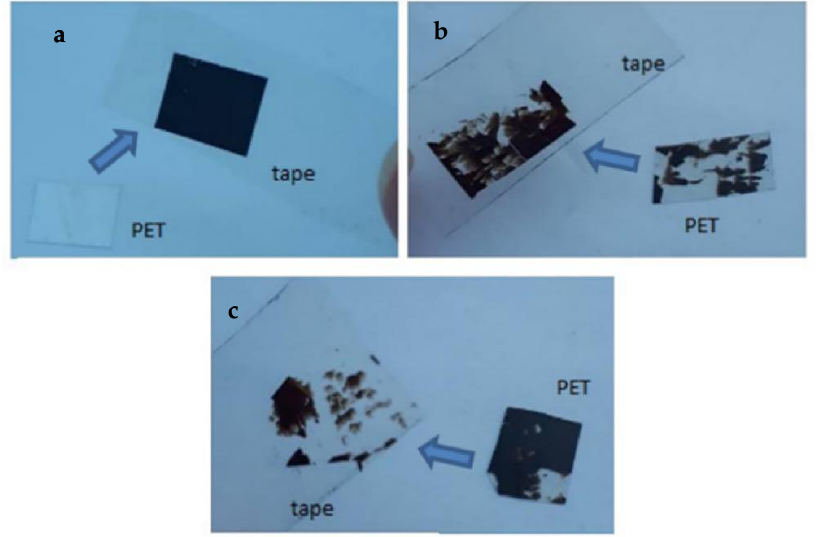
Figure 6. Digital photographs of ( a ) GO layers on PET substrates only, ( b ) on PDAC/PET, and ( c ) PDAC/plasma/PET removed by tape while maintaining the same pressure.